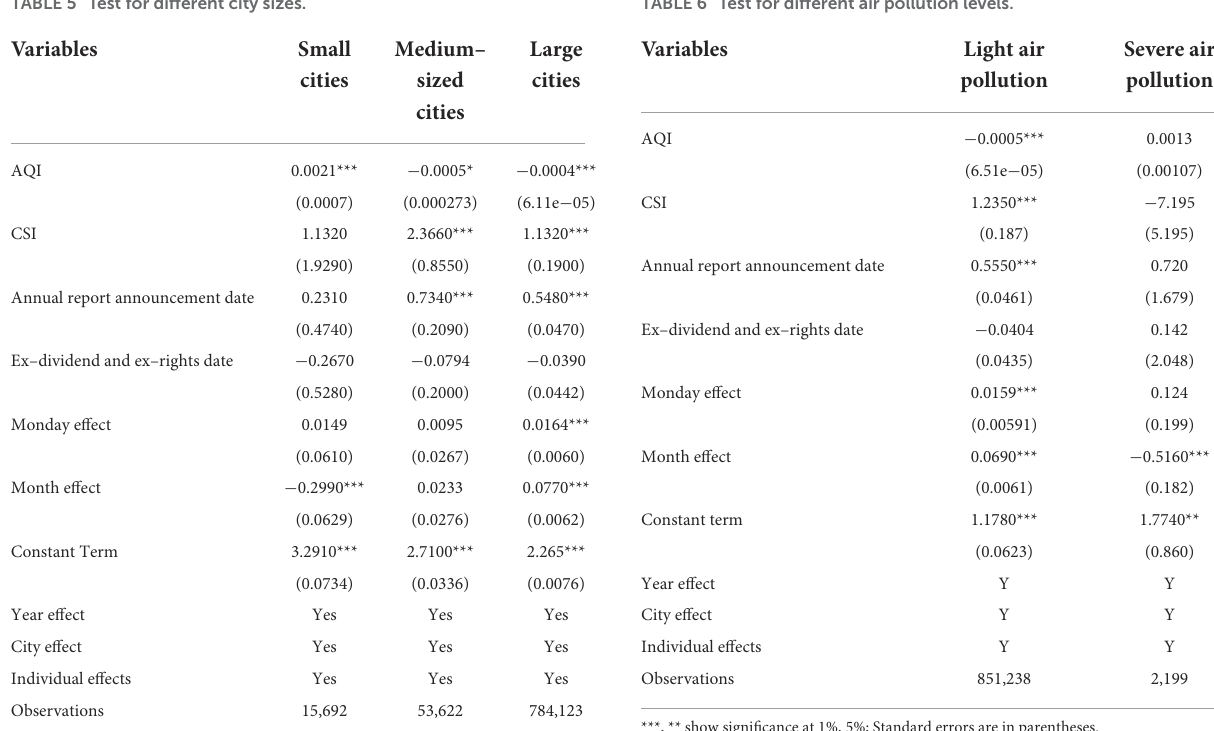
TABLE 5 Test for different city sizes. TABLE 6 Test for different air pollution